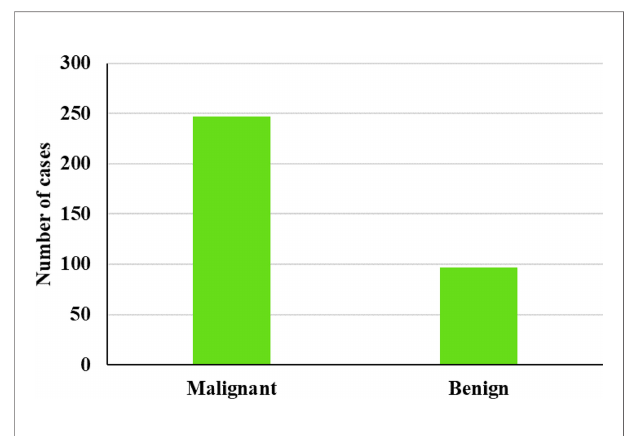
FIGURE 7 | US image